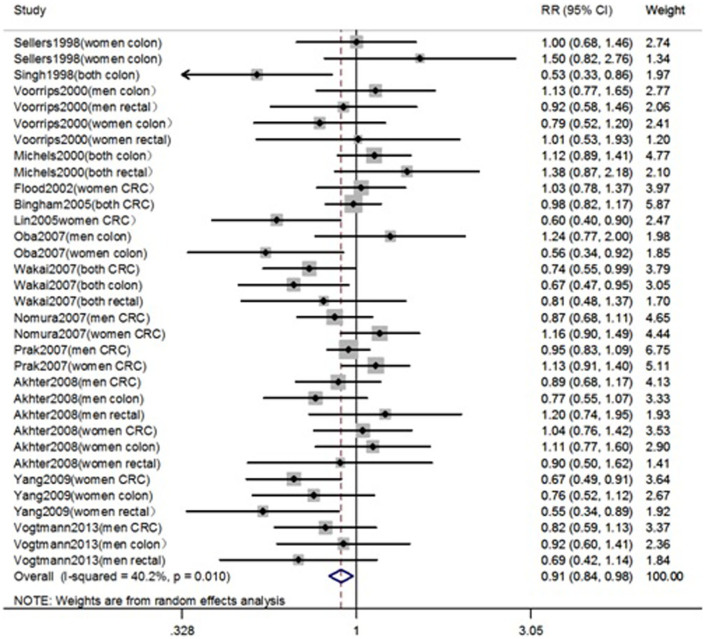
Forest plot of legumes consumption and risk of colorectal cancer.